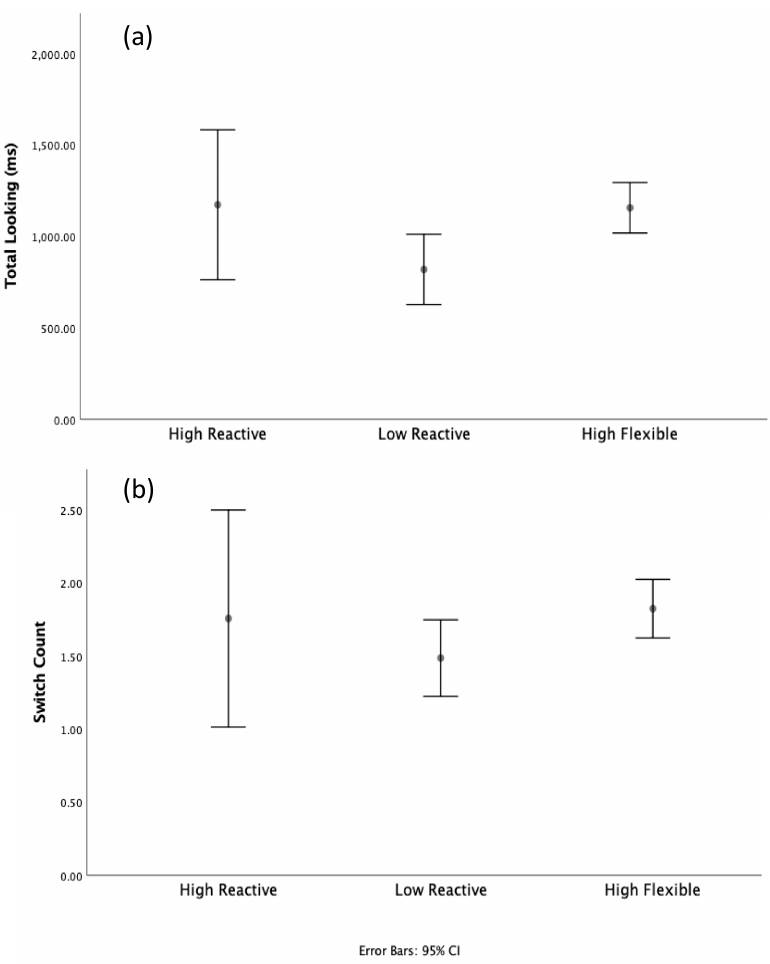
Figure 6. Mean look duration ( a ) and switch count ( b ) as a function of attention phenotype. CI: confidence